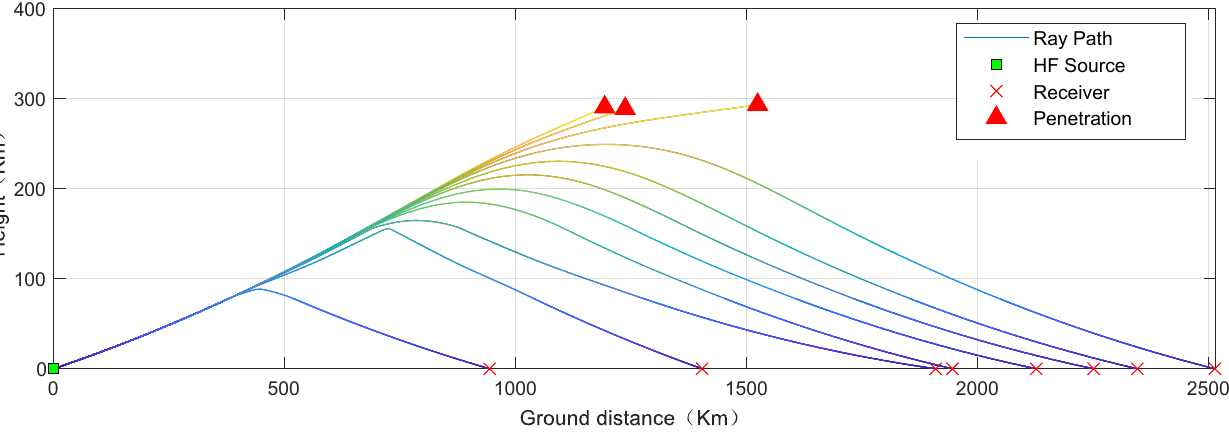
Figure A2. Simulation of HF signal ray tracing with different signal frequencies and a fixed emission angle of 10 ◦